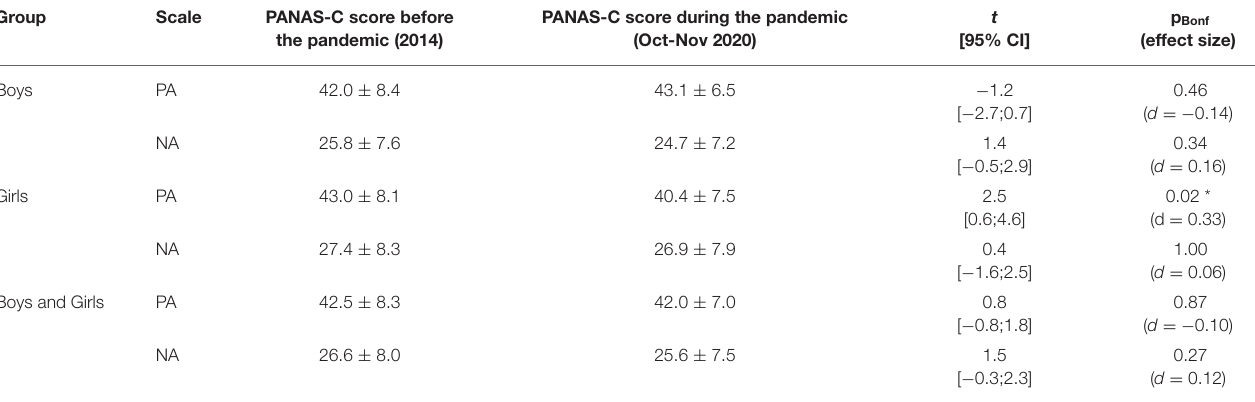
TABLE 2 | Comparison of Positive and Negative Affect Scale for Children (PANAS-C) data collected in Italian fourth and fifth graders before [2014, (75)] and during the COVID-19 pandemic (October-November 2020). Group